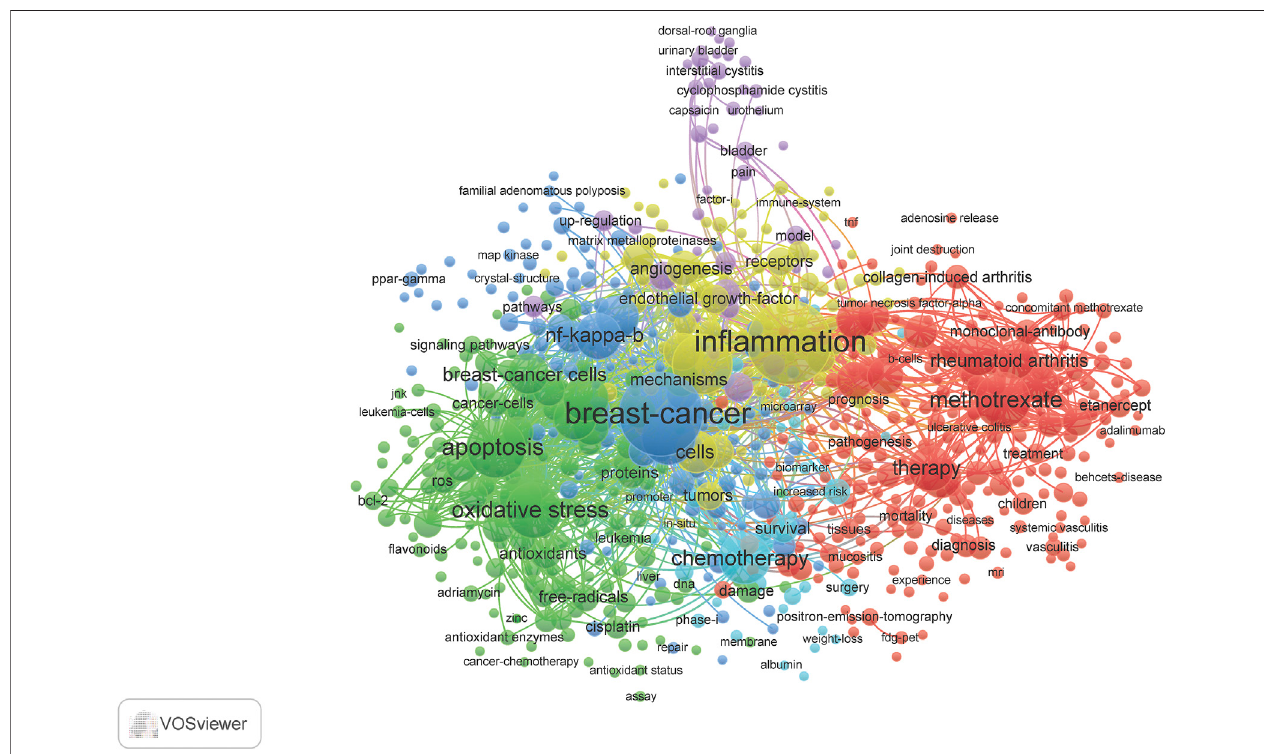
FIGURE 5 | Term map showing the visualization of 983 terms that occurred at least 25 times in documents between 2010 and 2019. Refer to Supplementary Table S4 for a complete list of